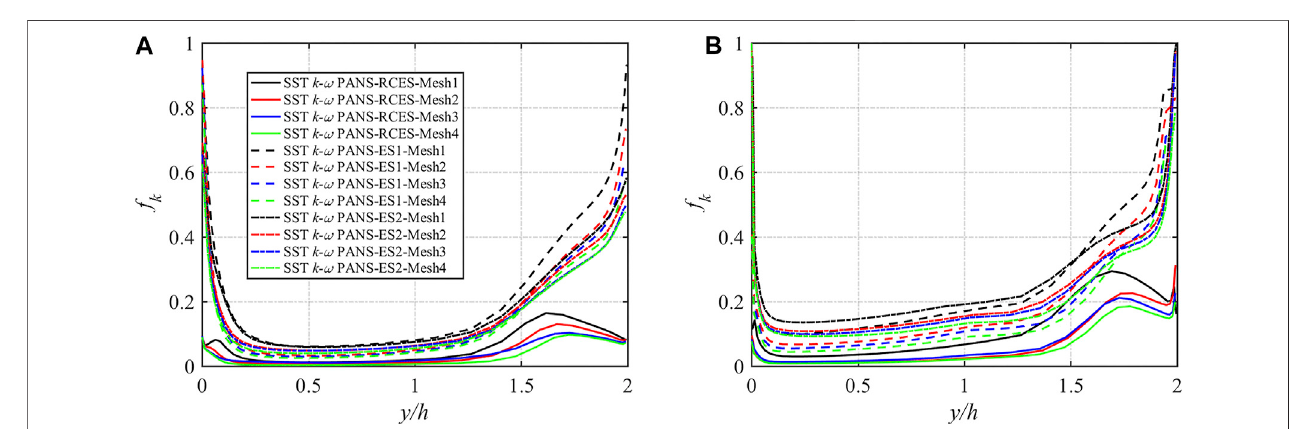
FIGURE 3 | f k distribution in rotating channel fl ow under different meshes: (A) Ro = 0.3 and (B) Ro = 0.6.